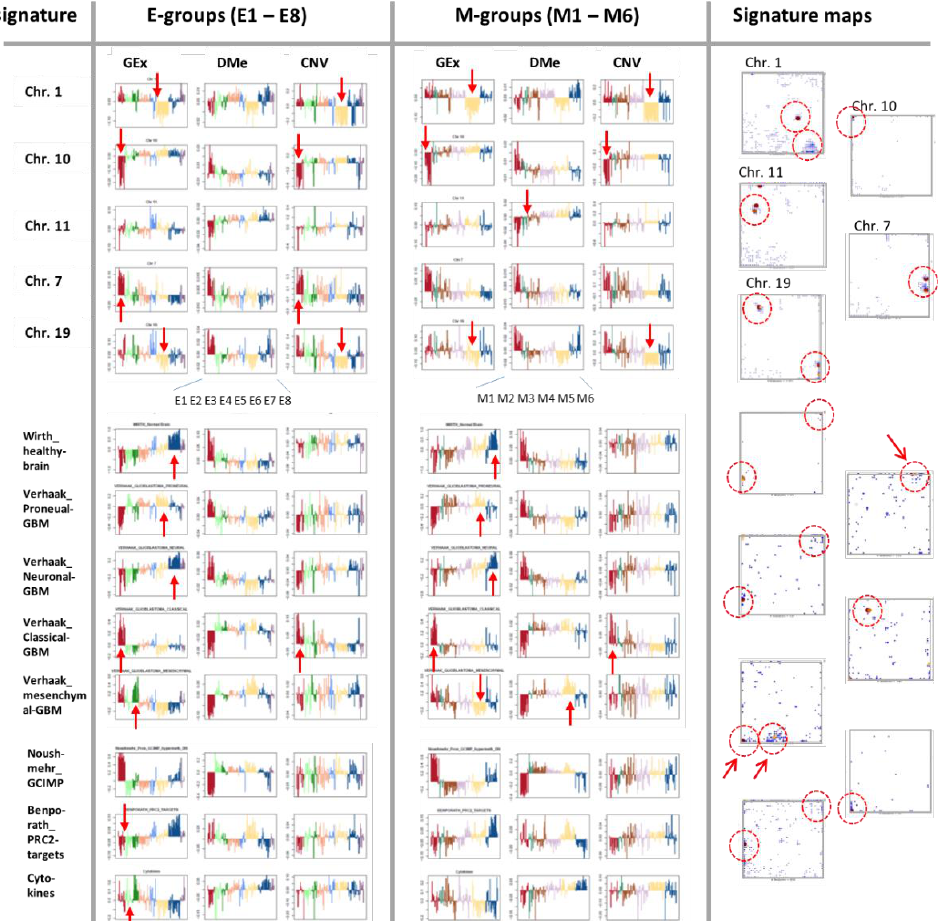
Figure A3. Omics (subtype-sorted) profiles and maps of selected gene signatures. Stratification into eight expression (E-) and six methylation (M-) subtypes show partly sharp subtype-specific differences of feature values not resolved in the genetic groups (see red arrows).